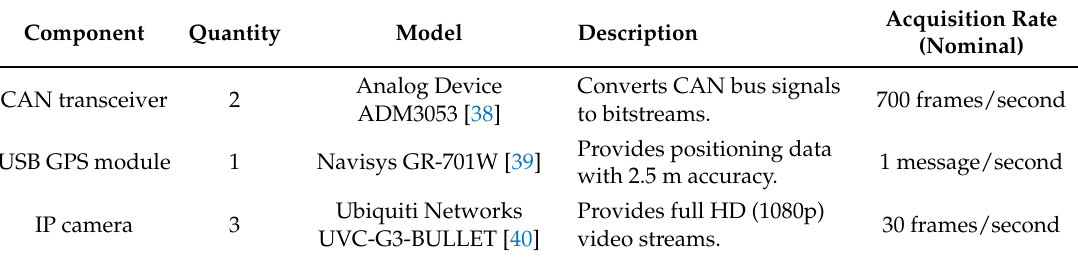
Figure 4. Three types of electronic components are utilized for collecting CAN, GNSS, and video data. Detailed specifications of these components are given in Table 3. Table 3. Specifications of data sources illustrated in Figure